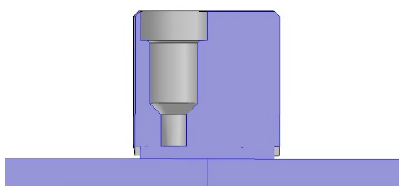
Figure 5. Picture showing the symmetry condition imposed on the transducer and on the plate, highlighted in blue.